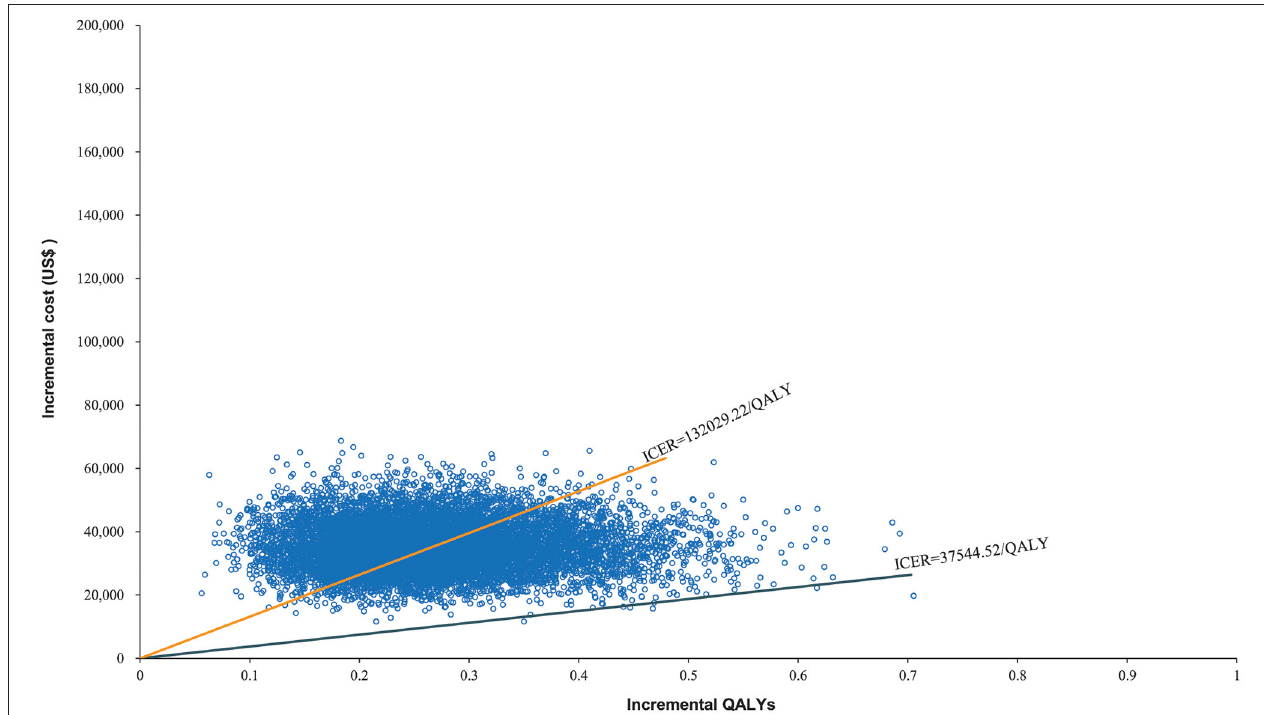
FIGURE 5 | Scatter plot of Monte Carlo sensitivity analysis.